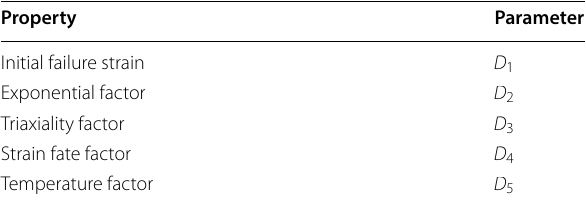
Table 1 Different parameters for the Johnson-Cook